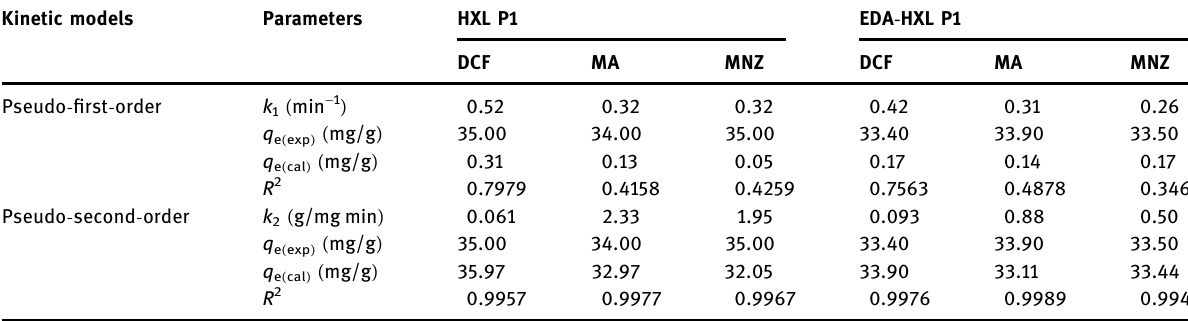
Table 6: Kinetic parameters for the adsorption of drugs onto HXL P1 and EDA - HXL P1 terpolymers Kinetic